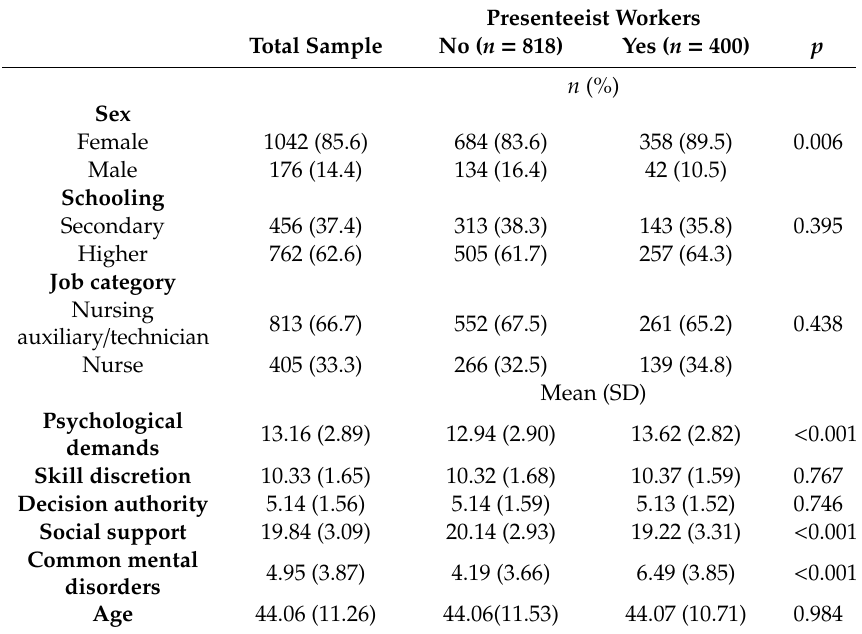
Table 2. Sociodemographics, psychosocial work factors and common mental disorders among nursing personnel—Brazil,